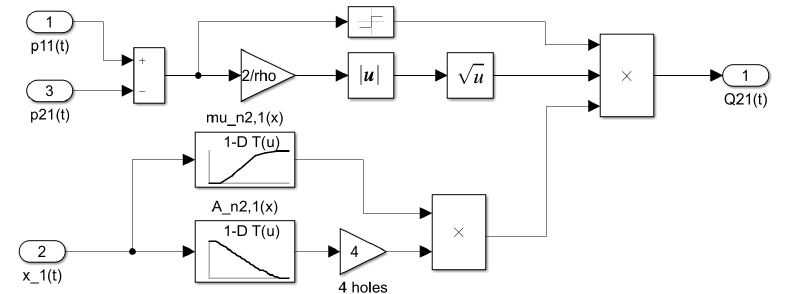
Figure 10. Simulink model of the n 2 nozzle flow